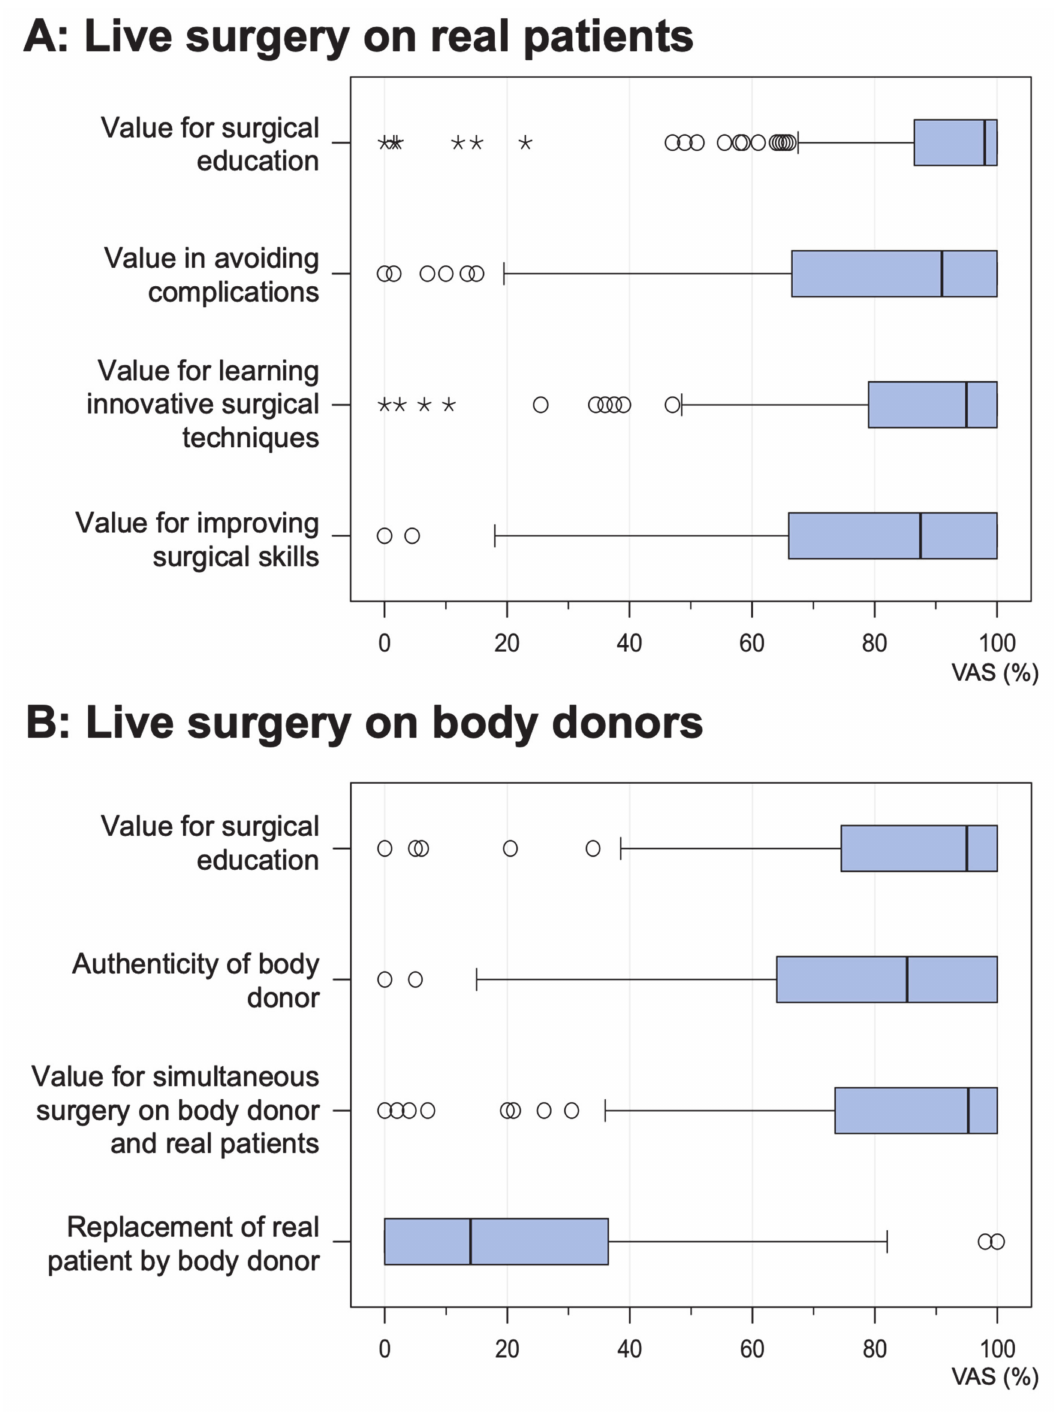
Figure 2. Evaluation (boxplots) of live surgery performed on ( A ) real patients and ( B ) a body donor. The answers were recorded on a continuous visual analog scale